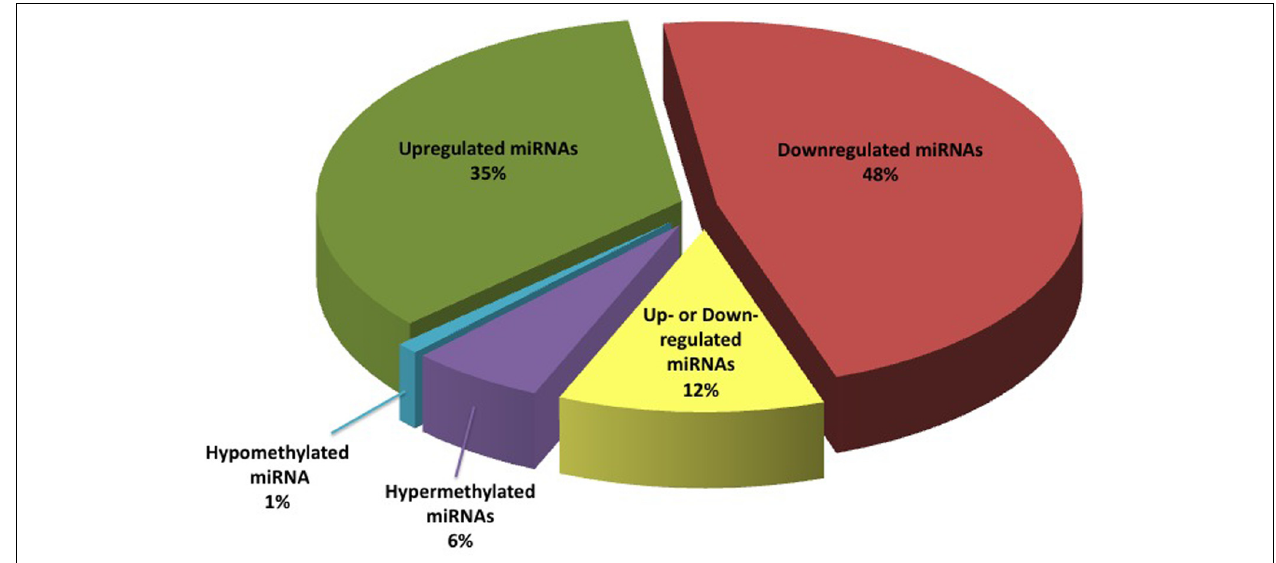
FIGURE 2 | Bladder cancer miRNA biomarker representation according to published